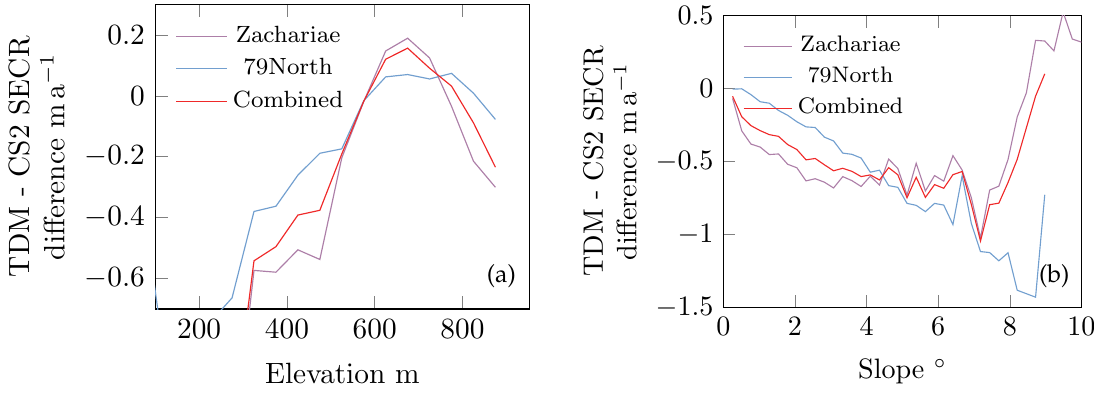
Figure 5. Differences of the TDM SECR map compared to the CS-2 SECR (TDM—CS-2) plotted over ( a ) elevation bins of 50m and ( b ) surface slopes calculated from the TDM global DEM. The differences are calculated for the two basins separately and for all points